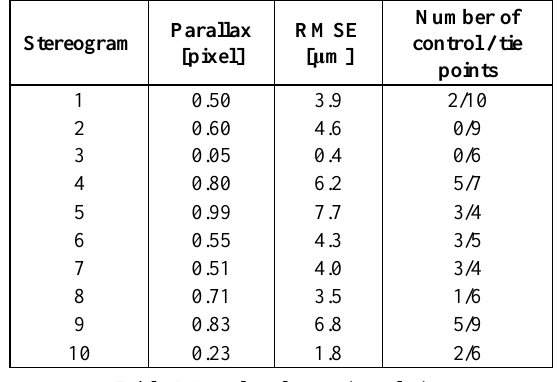
Table 2. Results of terratriangulation